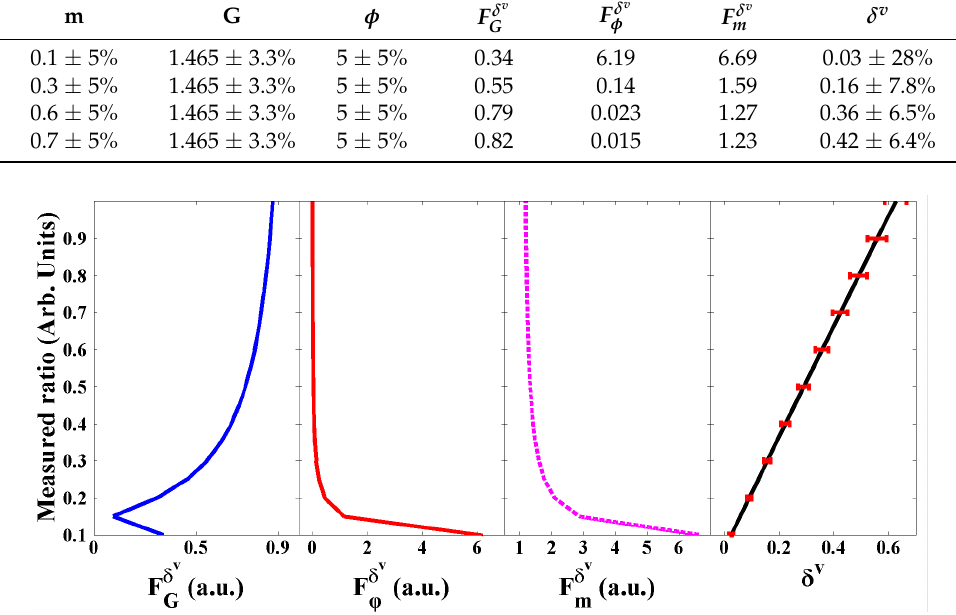
v δ F ; ( b ) propagation factor of the offset angle v δ ; ( b ) propagation factor of the offset angle F δ v G G F and ( d ) correlation between volume depolarization m